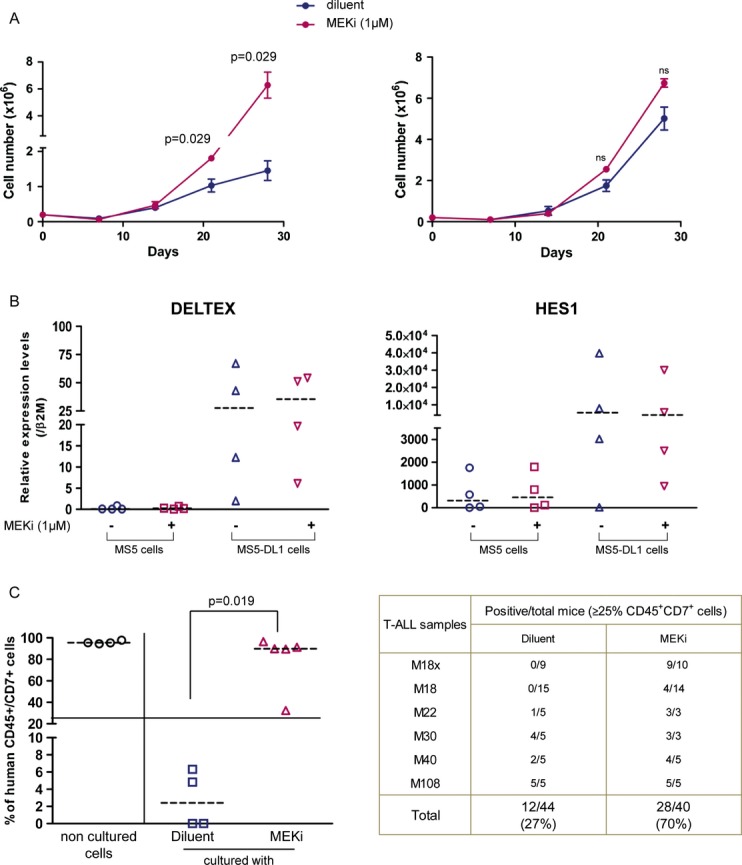
MEK inhibition stimulates the proliferation of T-ALL cells co-cultured with MS5 stromal cells and maintains T-LIC activityT-ALL cells were cultured on MS5 (left panel) or MS5-DL1 (right panel) stromal cells in the presence (MEKi) or not (DMSO alone) of 1 μM PD184352 (MEK inhibitor) for 28 days. Cells were counted by harvesting individual wells from 24-well/plates each week and using trypan blue or FACS. Shown are the cumulative data (mean ± s.d. of triplicates) for the M69 T-ALL sample as representative of the 14 MEKi-responsive T-ALL samples.HES1 and DELTEX expression levels in four individual T-ALL samples after 28 days of culture with MS5 or MS5-DL1 cells in the presence or absence of PD98059 (MEKi).Engraftment level in bone marrow of T-ALL cells that were cultured with or without MEKi (PD98059: M18, M22, M40; PD184352: M18, M108; U0126: M18, M30) for 1–2 weeks before injection. Left panel shows a representative experiment in which M18x T-ALL cells were injected in NSG mice directly or after 2 weeks of co-culture with MS5 cells in the presence or not of PD98059. The right panel provides a summary of the engraftment level of all tested T-ALL samples. Transplantations of M18, M22 and M30 T-ALL treated with PD98059 and U0126 were done in NS mice (Mann–Whitney non-parametric test).